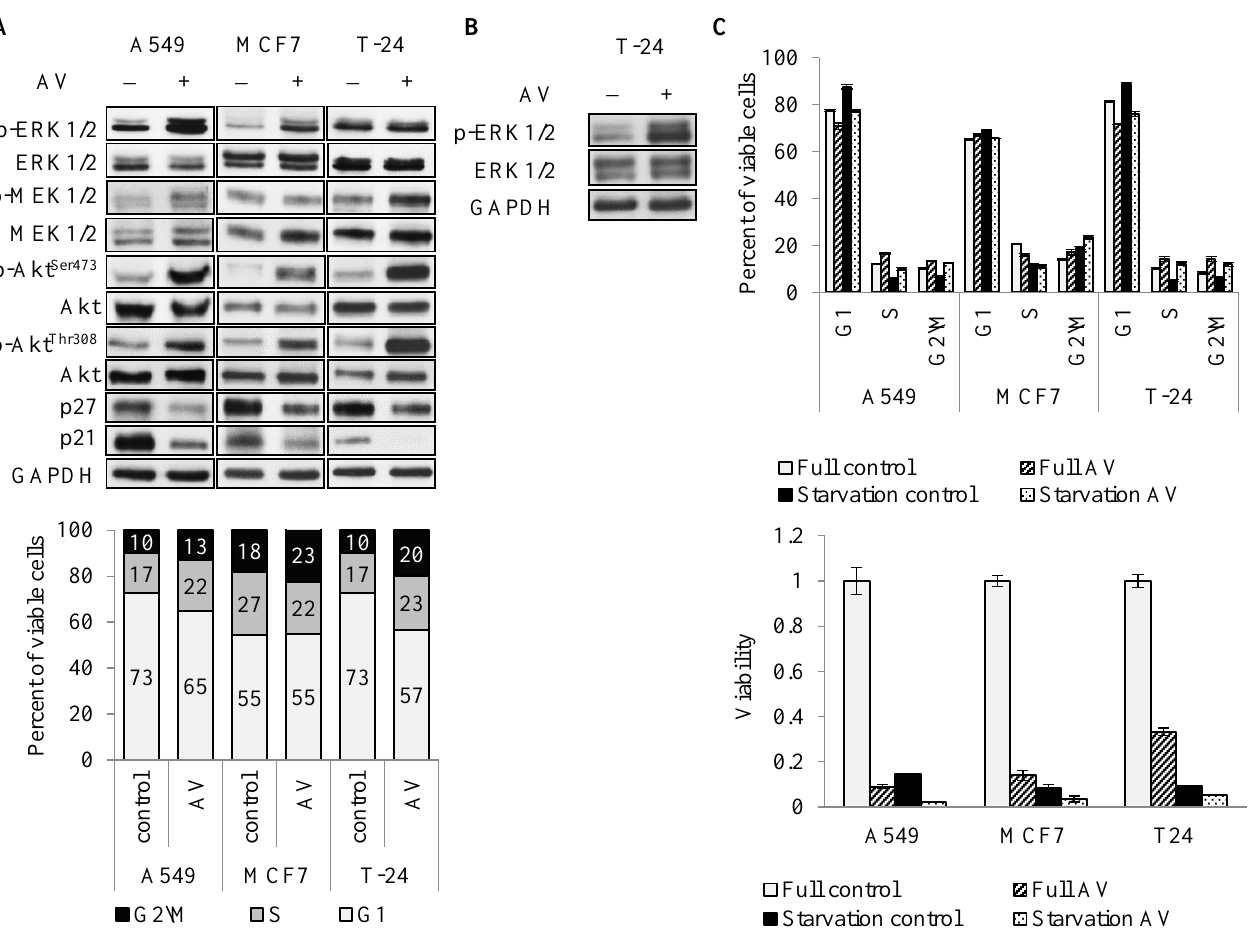
Figure 4. AV’s effect on proliferation pathways and cell cycle progression. ( A ) Cells were treated for 24 h with 2 mg/mL AV and either analyzed on Western blot for protein expression (upper panel) or subjected to cell cycle analysis by FACS (bottom panel, percent of viable cells in G0/G1, S and G2/M phases); ( B ) Western blot of T24 cells, treated with 2 mg/mL AV for 72 h; ( C ) AV (2 mg/mL) effect on cells in serum starvation conditions. Upper panel—distribution of cell cycle after 24 h treatment; bottom panel—viability after 72